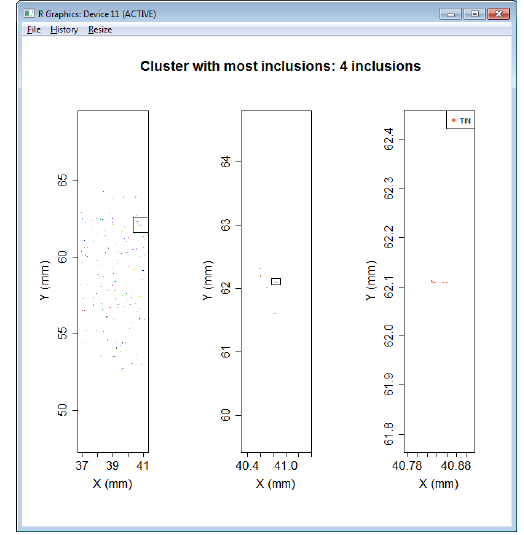
Figure 5: Cluster with most inclusions in the specimen.